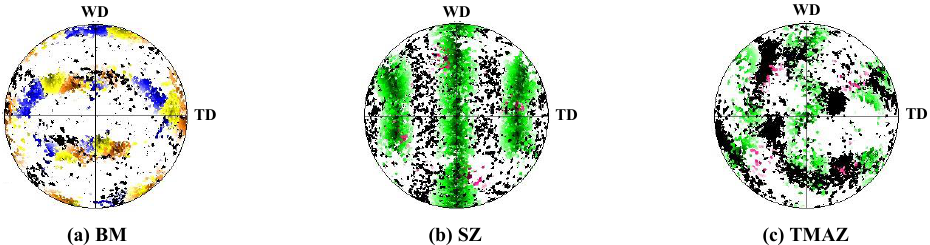
Figure 10. {1 1 1} pole figures of FSP sample: ( a ) BM; ( b ) SZ, and ( c ) TMAZ. Texture components: brown (brass), blue (copper), yellow (S), green ( B fiber), red (Cube).